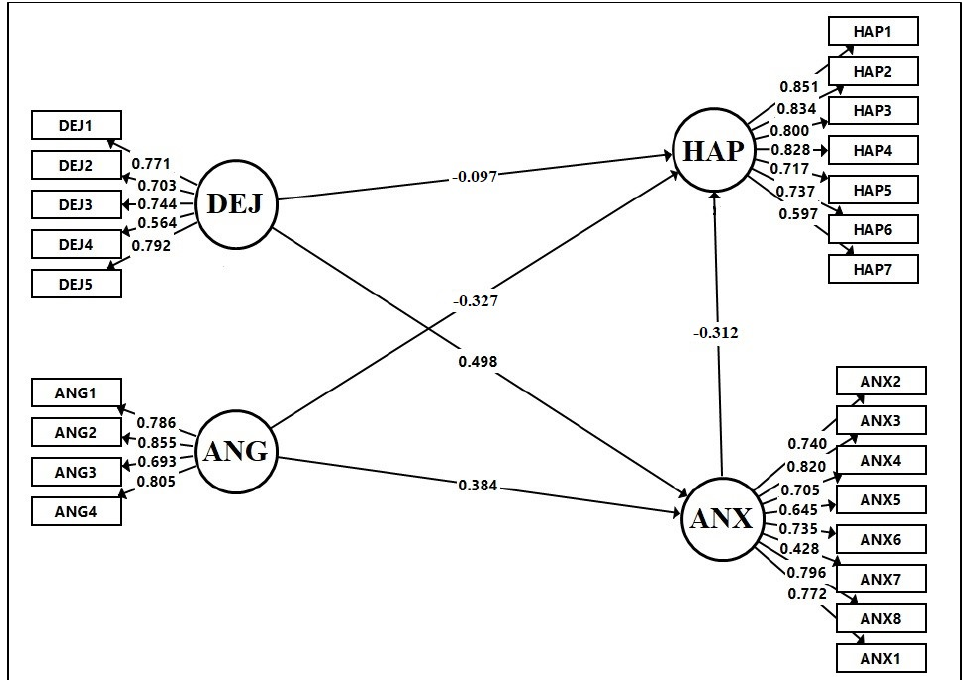
Figure 2. A preliminary structural model considering external loads.